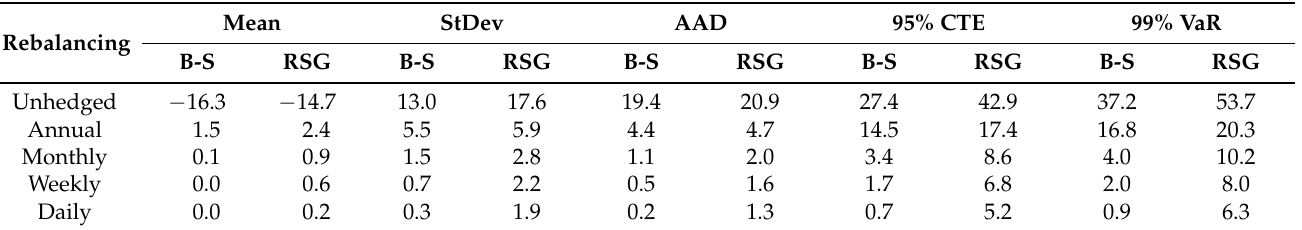
Table 2. Risk measures for the insurer’s net loss at maturity based on the Black–Scholes model and the RS-GARCH model with parameter